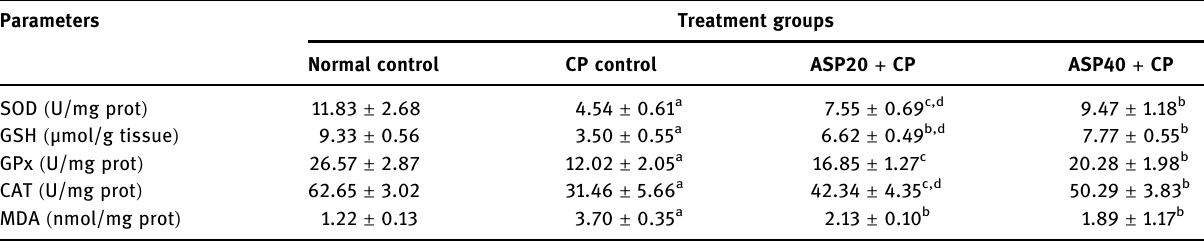
Table 3: E ff ect of ASP on bladder oxidative stress and antioxidant in CP - treated rats